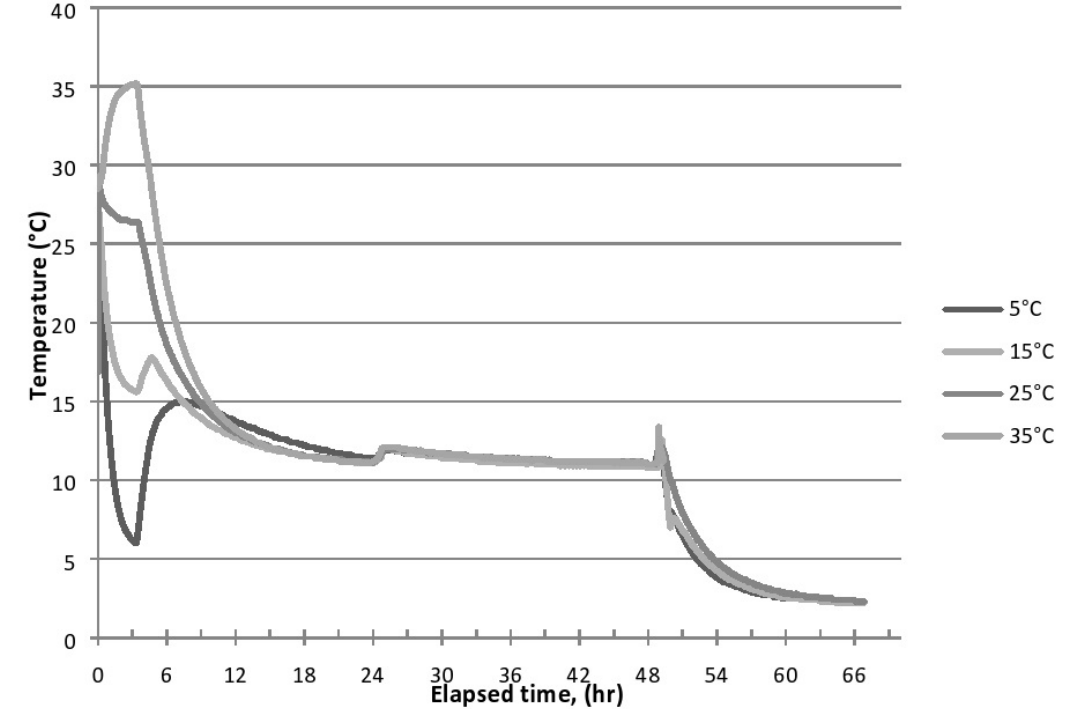
Figure 2. Temperature decline rates of the bull beef M. longissimus lumborum muscles assigned to additional electrical stimulation and various pre-rigor holding temperature (for 3 h) methods. The samples (in plastic bag) were then placed in boxes at 10°C for 24 h post mortem. Then samples were vacuum packed and aged at 10°C for next 24 h (in total 48 h post mortem) and further aged at 1°C until 14 days post